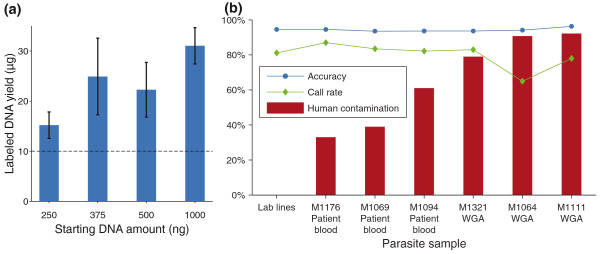
Field sample analysis with the CNV-SNP array. (a) The manufacturer-recommended starting amount is 1,000 ng of DNA to produce at least 10 μg of labeled product. However, 250 ng of parasite DNA consistently produced sufficient labeled product when using 65% AT nonamers. Error bars indicate one standard deviation. (b) Hybridizations with field samples - straight from patient blood, or whole genome amplified - produced microarray data on par with standard lab clones, even when significant human DNA contamination was present. Microarray accuracy was determined through Illumina sequencing of lab-adapted parasites. Patient blood samples were hybridized with the addition of 1× Denhardt's solution while WGA samples were not.